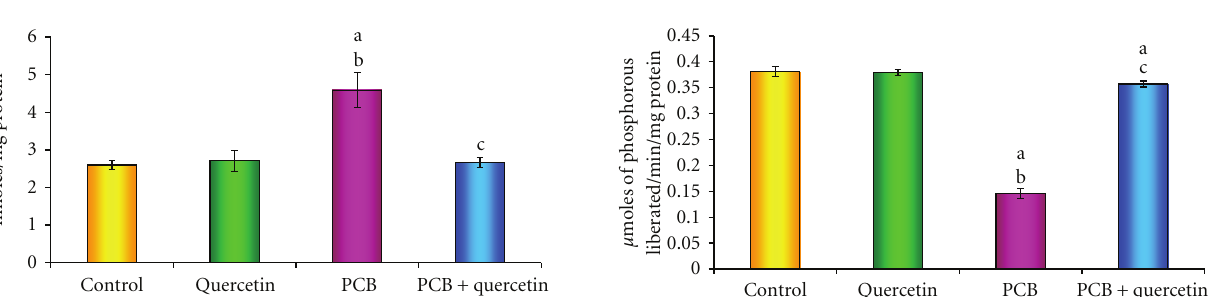
Figure 6: E ff ect of quercetin on acetyl cholinesterase in hippocam- pus of PCBs-exposed adult rats. Each bar represents mean ± SEM of 6 animals. Statistical significance is at P < 0 . 05 (a: Control versus others; b: Quercetin versus PCB, PCB + Quer; c: PCB versus PCB +